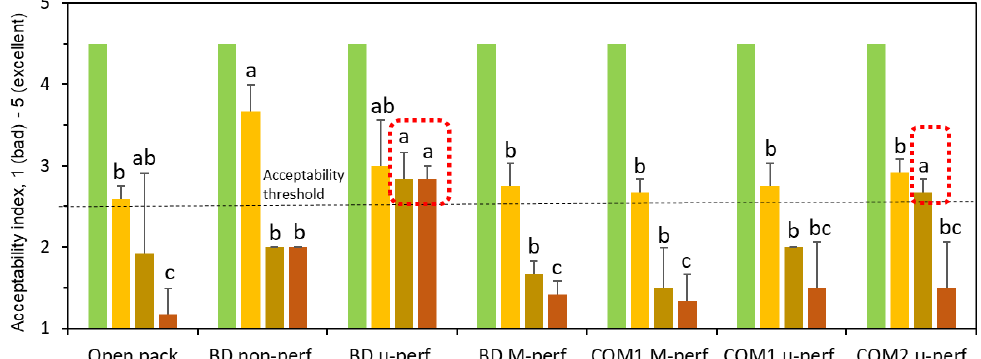
Figure 9. The effect of packaging methods on general acceptability of bananas after 3 days of simulated distribution at 15 °C and 1, 3 or 5 days of shelf life/home storage at 24 °C. Package designations are the same as in Figure 2. Error bars represent standard errors of three replications. Within each sampling day, different letters above the bars indicate significant differences between packaging types at p ≤ 0.05, according to Tukey ’ s HSD test. Red dotted frames designate packaging treatments that maintain fruit quality above the acceptability threshold after the extended shelf life of 3 and 5 days.